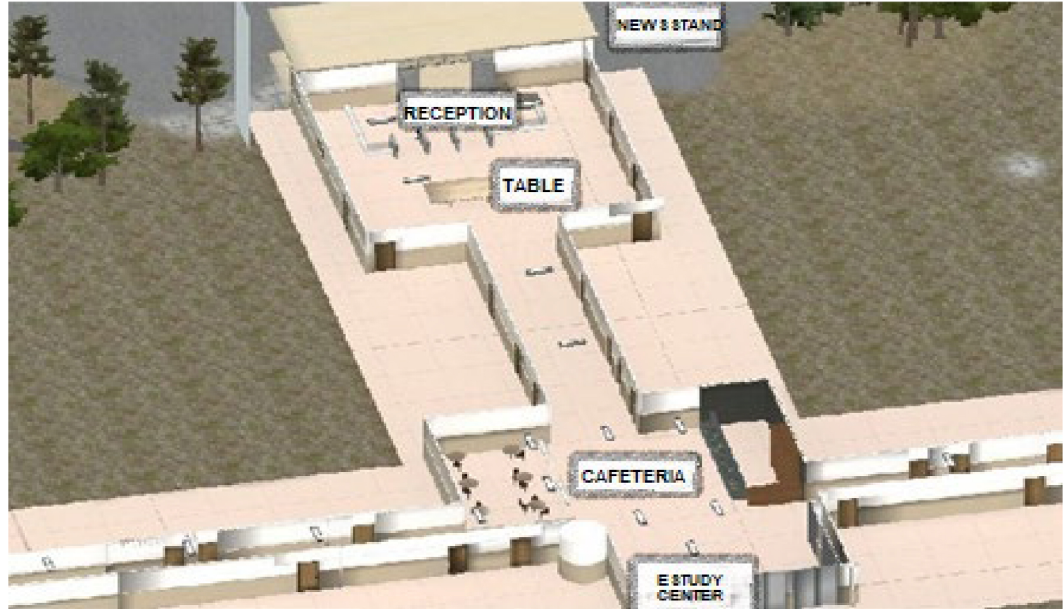
Figure 1. Route in the real and virtual tasks (aerial view of the virtual